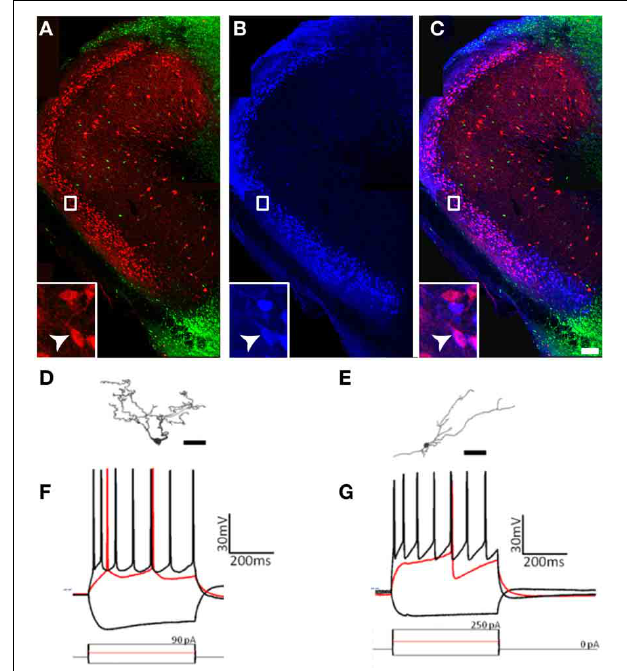
FIGURE 8 | Cells of pars externa have unique molecular and physiological properties. (A–C) Calbindin-positive, GAD67-negative cells in pars externa project to the contralateral olfactory bulb. (A) GAD67-GFP cells (green) do not colocalize with the large, dense population of calbindin (red) positive cells in pars externa. (B) Pars externa cells that project to the contralateral olfactory bulb (blue) are visualized 3 days after a retrograde tracer injection. (C) Merged image of (A) and (B) shows many, but not all of the pars externa cells projecting to the contralateral bulb to colocalize with calbindin (white arrow, inset). Scale bar = 200 µ m. (D–G) A small sampling of pars externa cells show various phenotypes. (D,E) Cameralucida drawings of two pars externa neurons. Scale bars = 100 µ m. (F,G) Voltage responses (top) for three current steps (bottom) in the cells shown in (D,E) , respectively. Red traces are at rheobase. Dotted line indicates transmembrane voltage of −